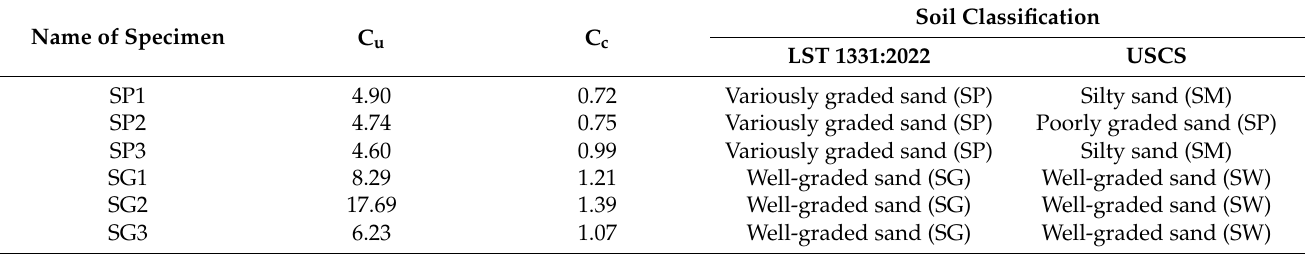
Figure 4. Particle size distribution curves of soils under discussion. Classification of all samples according to LST 1331:2022 [19] and the Unified Soil Classification System (USCS) [20] is presented in Table 1, as well as uniformity coefficients (C u ) and coefficient of curvature (C c ). The density of each specimen was controlled at 100 ± 5% dry density. Table 1. Classification of specimens according to LST 1331:2022 and USCS.